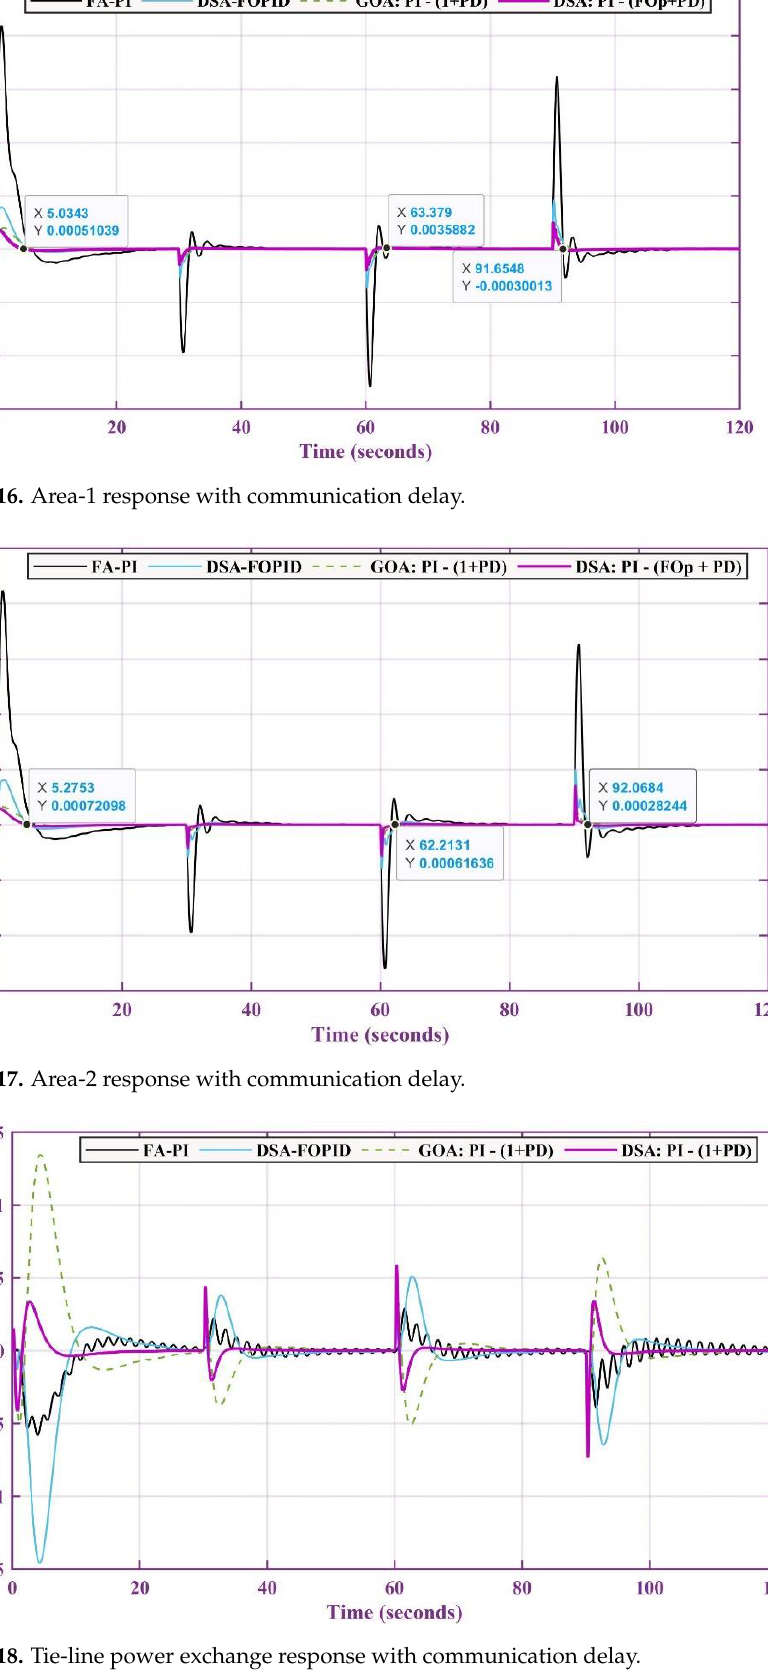
Figure 18. Tie-line power exchange response with communication delay.